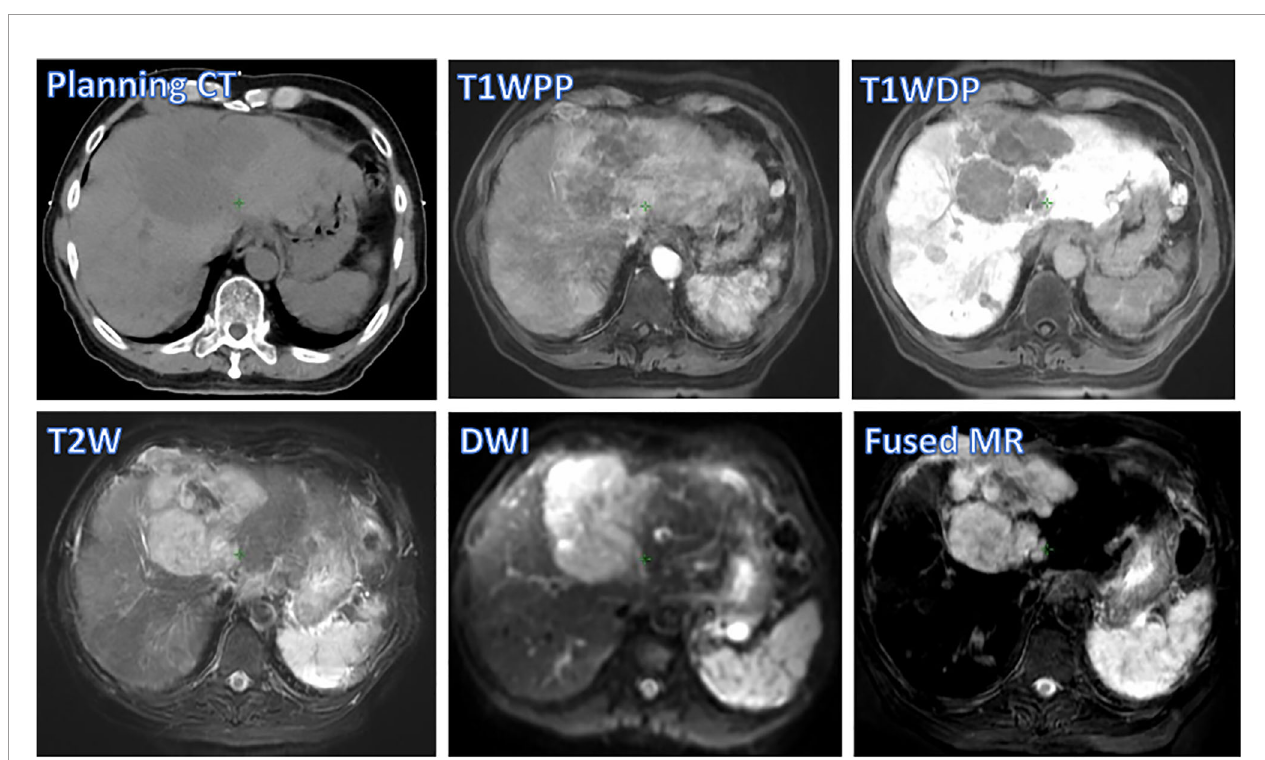
FIGURE 2 | Tumor visibility of a representative patient on various images: planning CT, four original MR sets (T1W PP , T1W DP , T2W, and DWI), and fused MRI. T1W PP , T1-weighted MRI at portal-venous phase; T1W DP , T1-weighted MRI at 19-min delayed phase; T2W, T2-weighted; DWI, diffusion-weighted MRI.